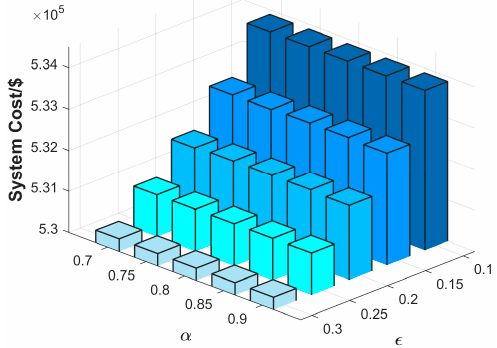
Figure 6. Objectives with different values of 𝜀 and 𝛼 .